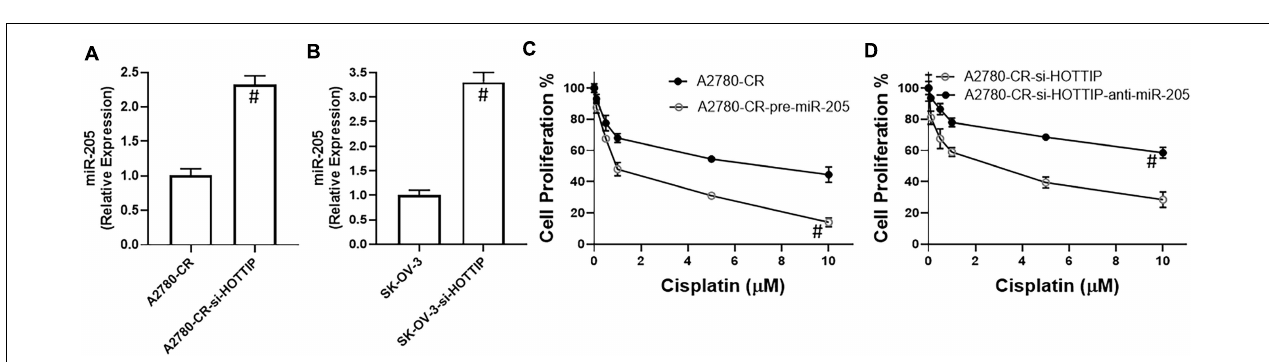
FIGURE 2 | (A) Anchorage-dependent and (B) anchorage-independent growth of A2780-CR and SK-OV-3 cells with and without silencing of HOTTIP was measured, as mentioned in section “Materials and Methods.” Anchorage dependent growth was allowed for three weeks while anchorage-independent growth in soft agar was allowed for 4–5 weeks. (C) NF- κ B activity assay was performed using the methods mentioned and the absorbance was read at 450 nm. (D) Expression levels of stem cell markers were determined by RT-PCR in A2780 cells with and without the silencing of HOTTIP, with GAPDH being evaluated as internal control. # p < 0.05.